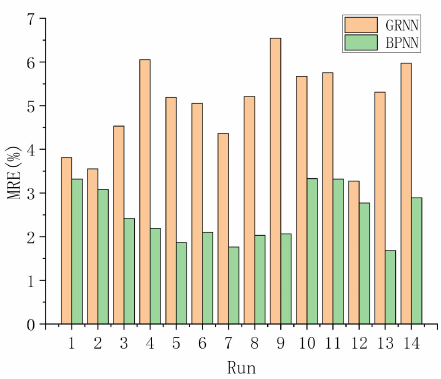
Figure 11. MRE of GRNN model and BPNN model based on 10 runs of experimental